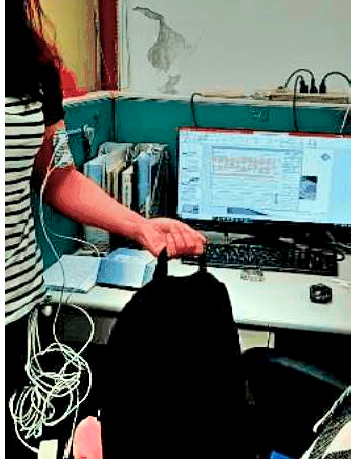
Figure 12. Action of measuring Electromyography (EMG).